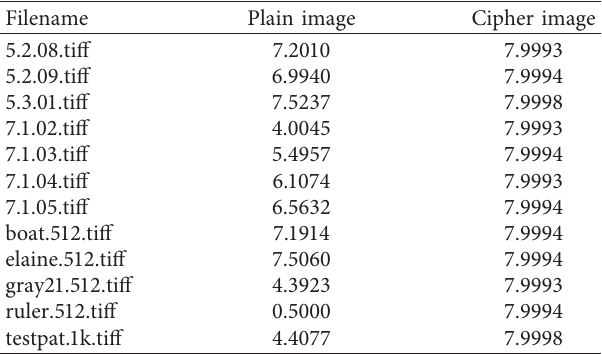
Table 8: Information entropy test results of plain images and cipher images.